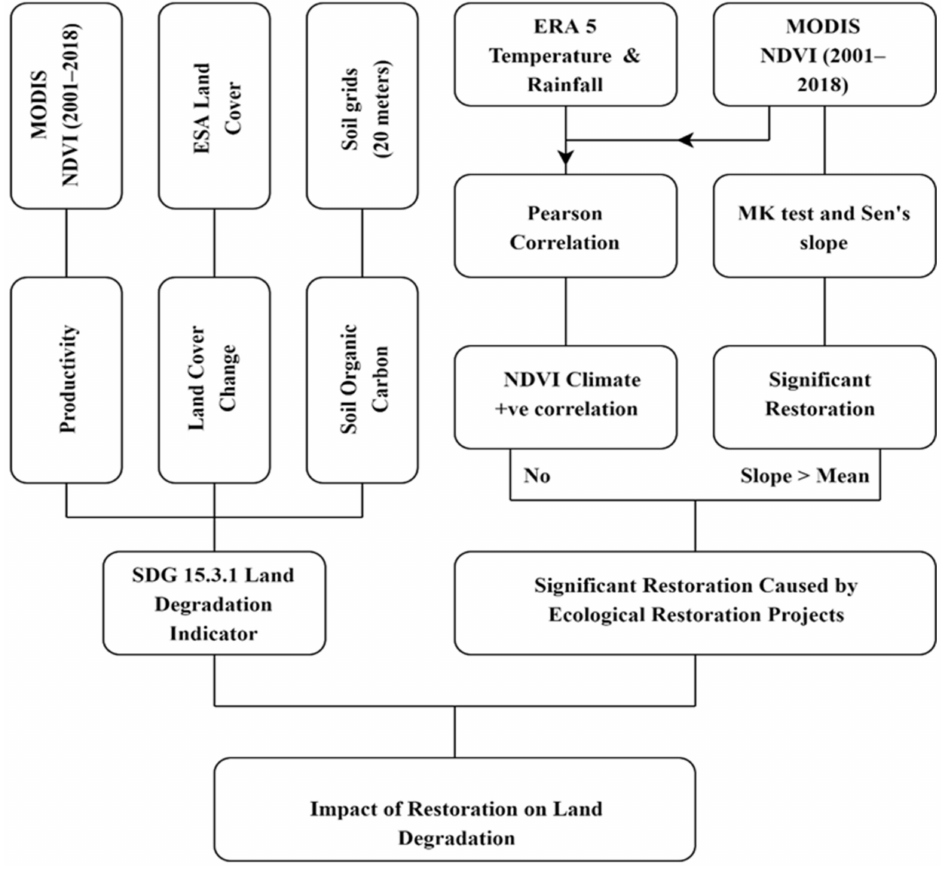
Figure 3. Conceptual approach of the study to detect the impact of restoration on land